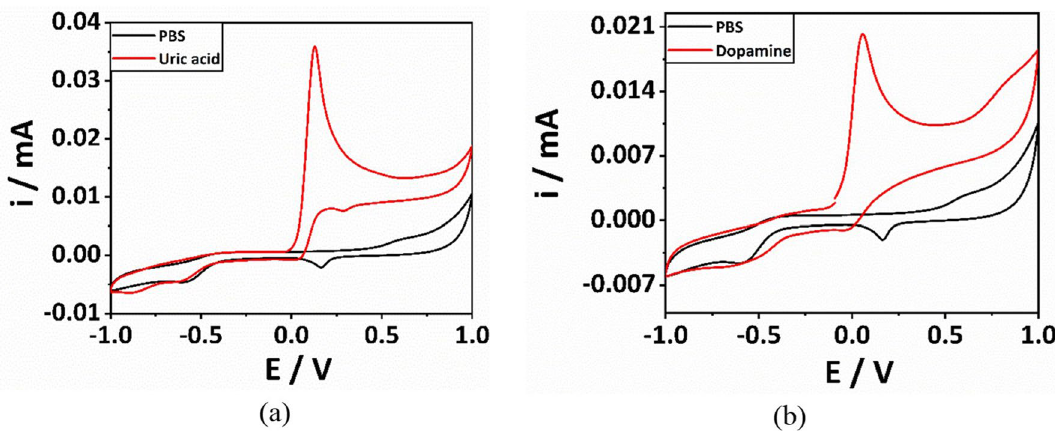
Figure 8. CV response for ( a ) 1 mM Uric acid and PBS and ( b ) 1 mM Dopamine and